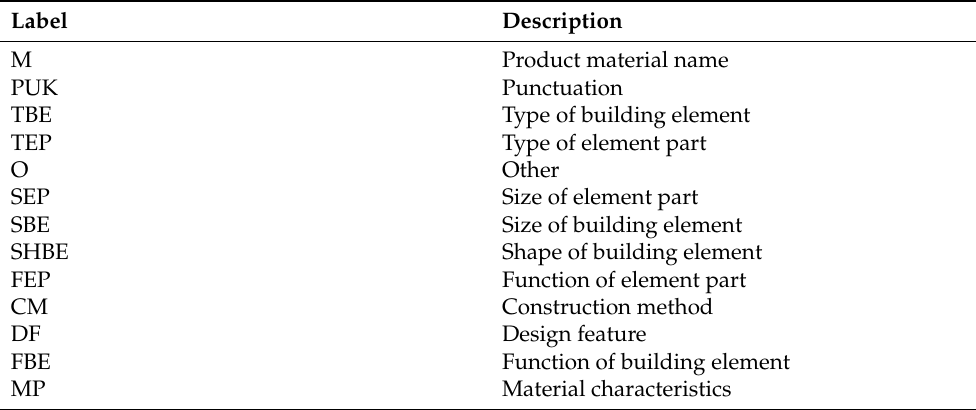
Table 1. Predefined labels and their